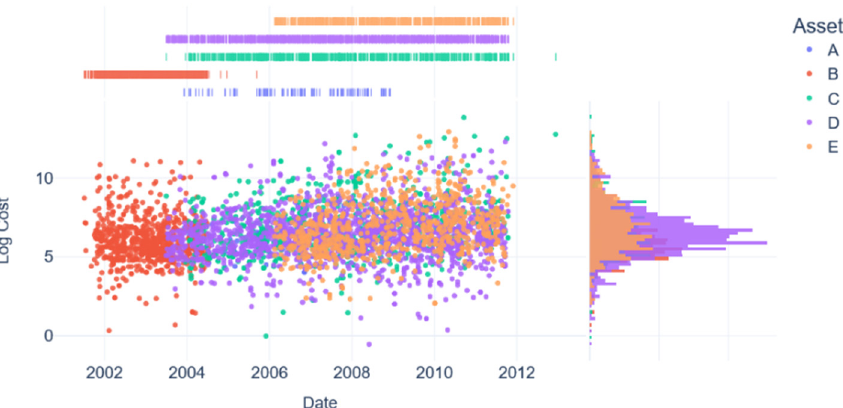
Figure A1. A marginal distribution plot of the cost of each asset over time.